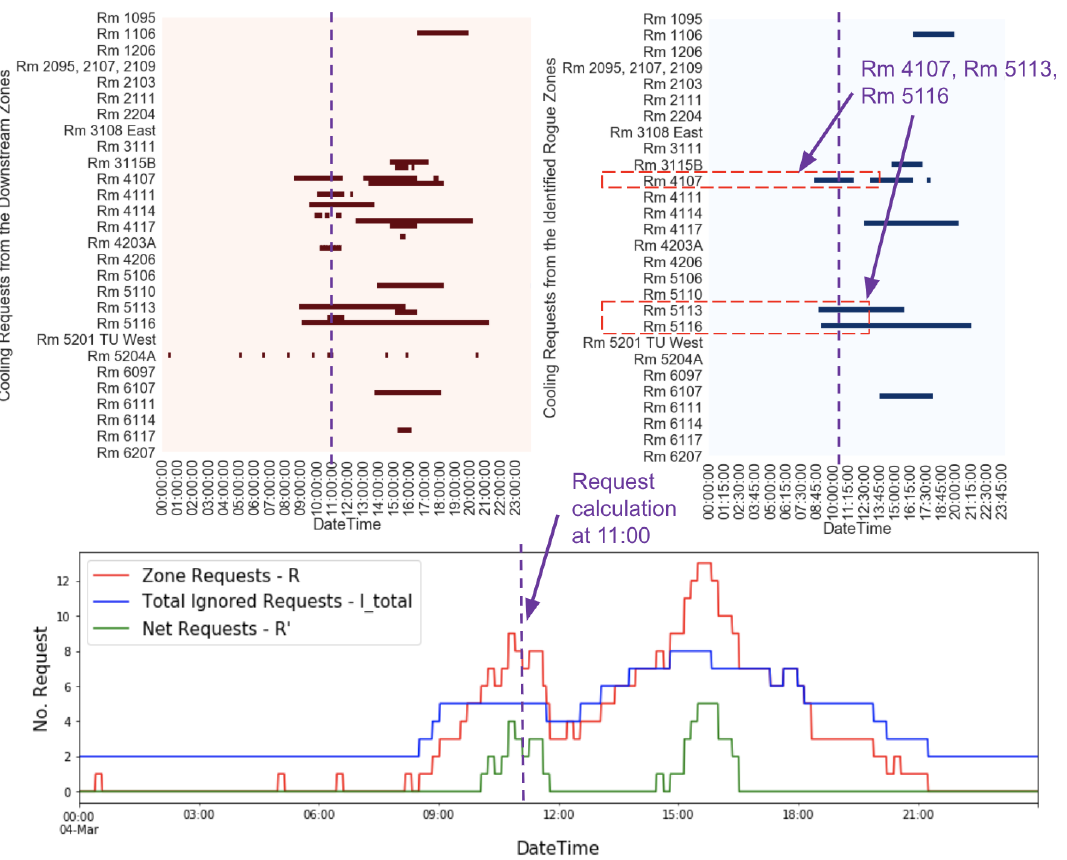
Figure 6. Zone requests per zone (upper left), the ignored requests per zone (upper right), the sum of the requests, the total of ignored requests and the net requests for all the zones of AHU01 on 4 March 2020. The vertical line marks 11 a.m. on all the plots.